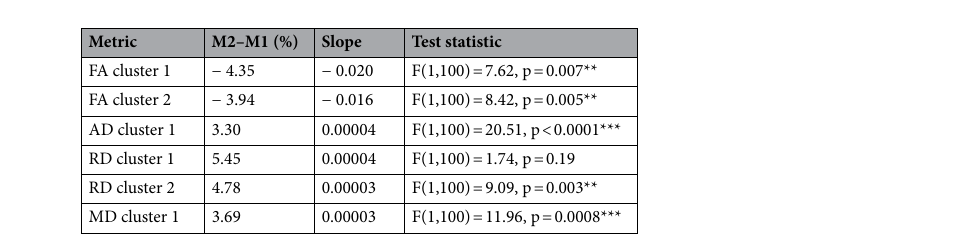
Table 3. Percentage of longitudinal changes in DTI metrics, linear regression slopes and significance of slopes of each significant cluster. FA fractional anisotropy, AD axial diffusivity, MD mean diffusivity, RD